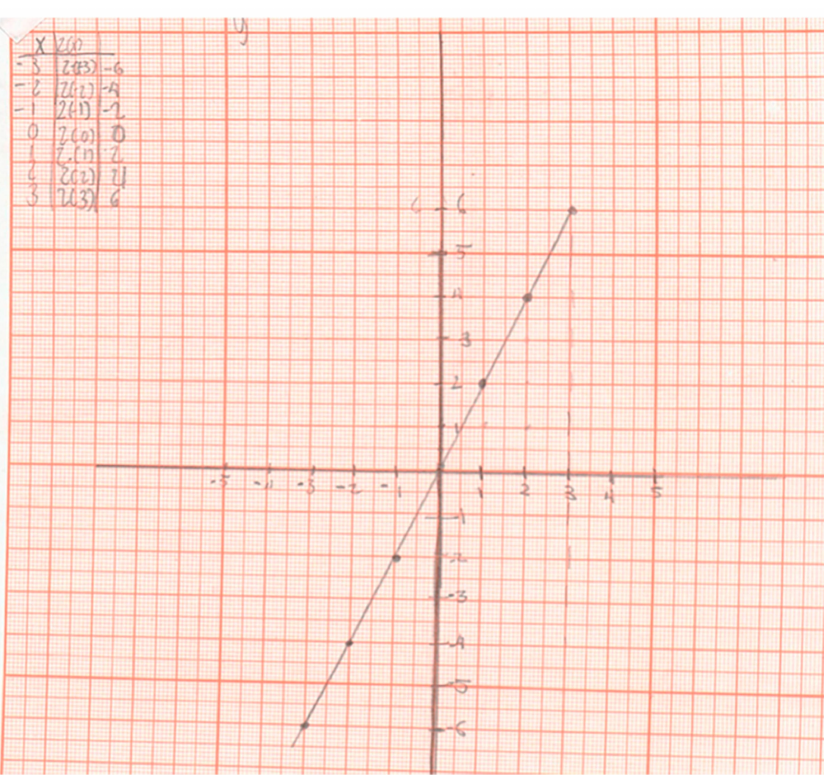
Figure 4. Student’s production: tabulation without respecting the proposed interval. Note: The activity requested the graphical representation to be limited to the interval [0, 3]. In the upper-left part of the image, the reader can see that the interval [ − 3, 3] was tabulated considering only